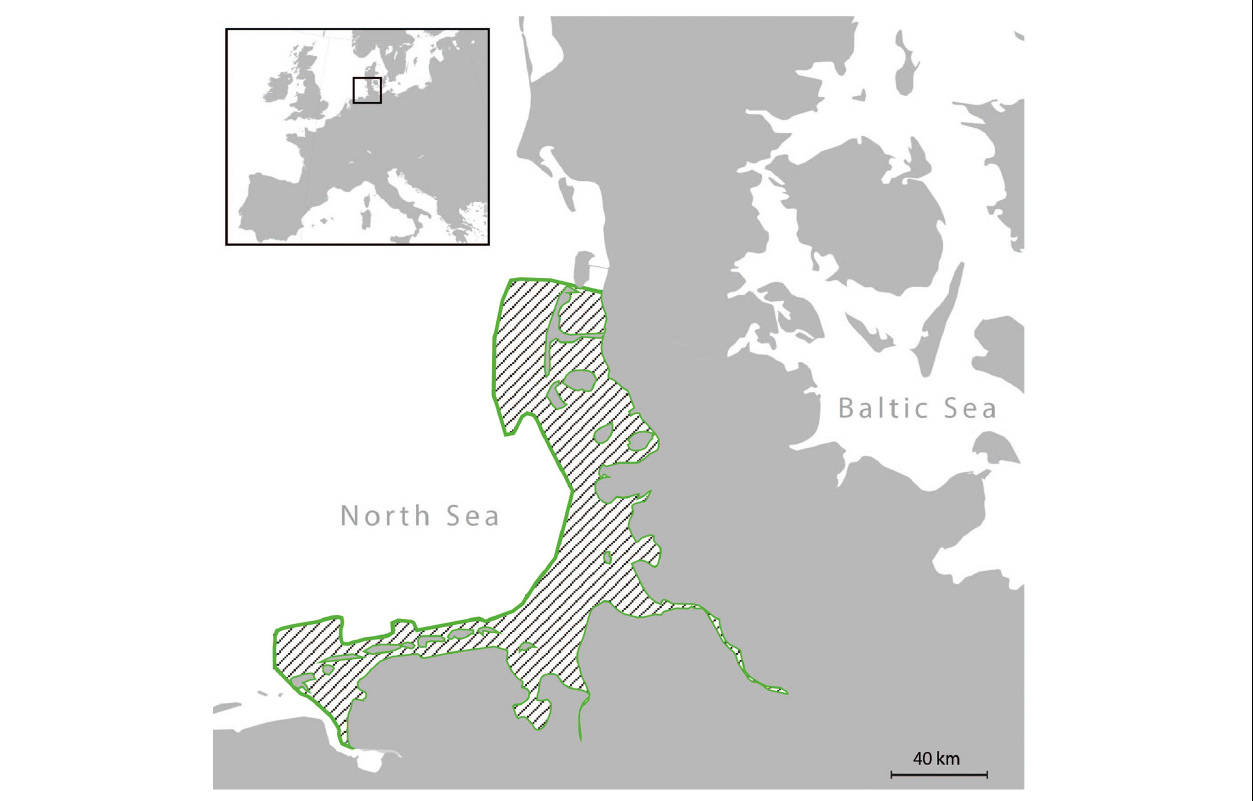
FIGURE 1 | Map of the German Wadden Sea. During the summer/fall of 1988, all examined specimens were collected along the coast of the German Wadden Sea (area outlined in